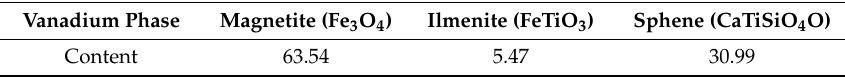
Table 2. Chemical phase analyses of vanadium in the concentrate wt